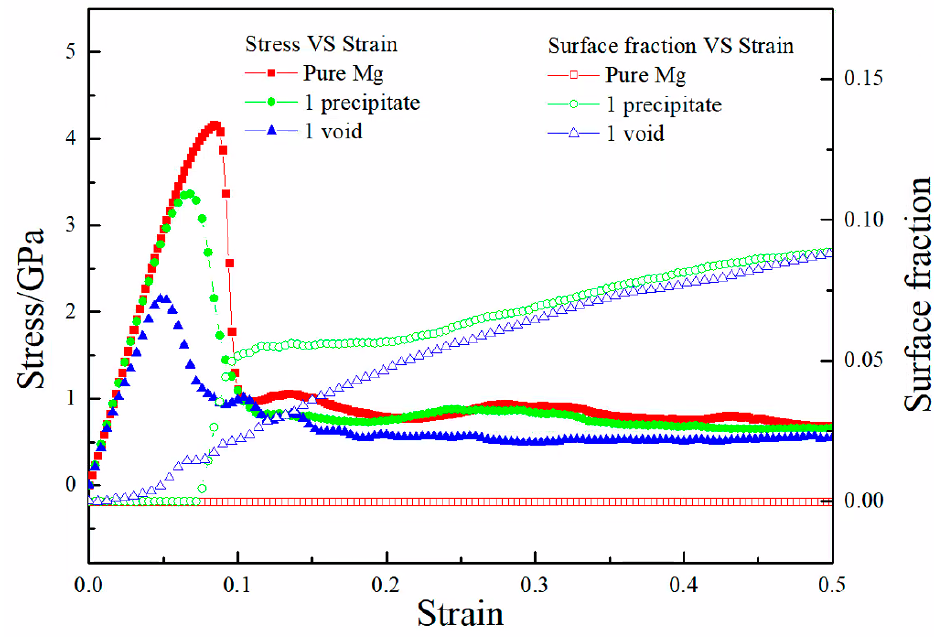
Figure 7. Comparisons of ultimate stress and free surface fraction growth among the three sys- tems.